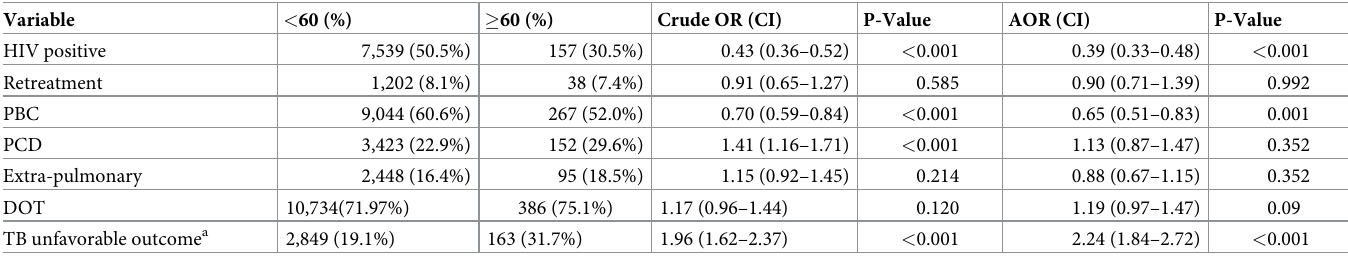
Table 2. Comparison of elderly and non-elderly TB